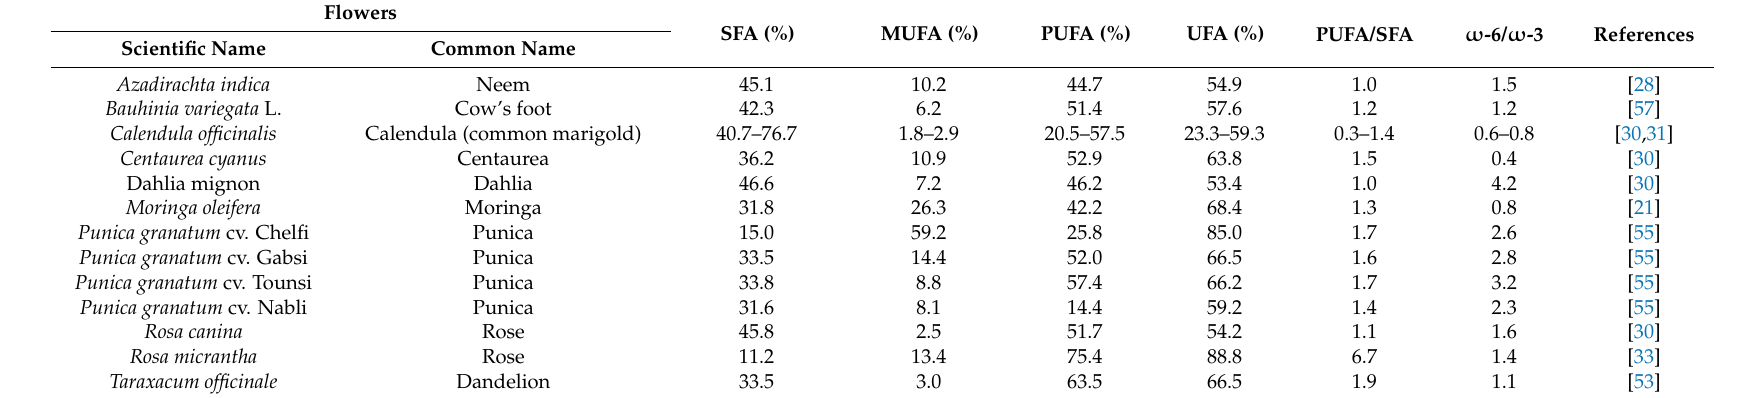
Table 3. Saturated, monounsaturated, polyunsaturated and unsaturated fatty acids in edible flowers